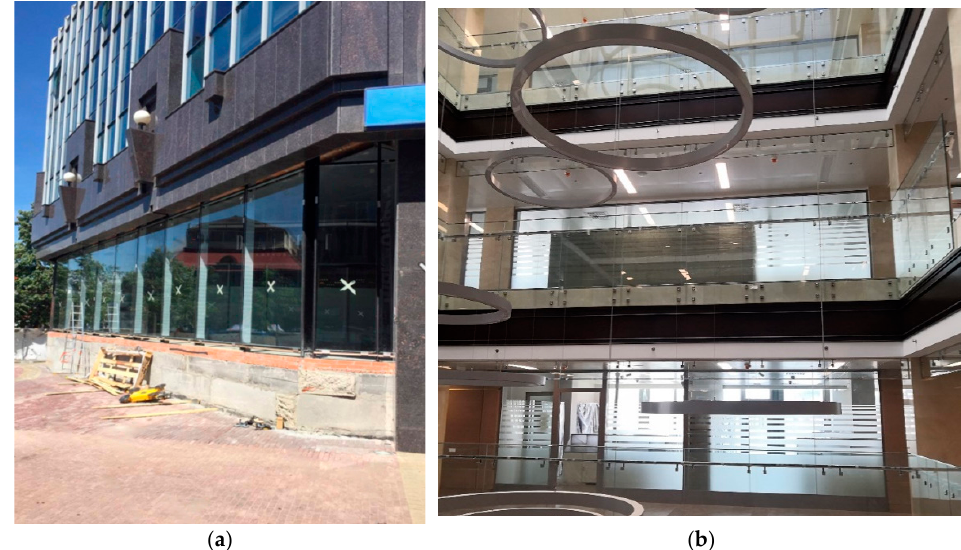
Figure 1. Business center “Chelyabinsk City”: ( a ) facade and ( b ) smoke-proof all-glass screen in the atrium. Photo by the authors.